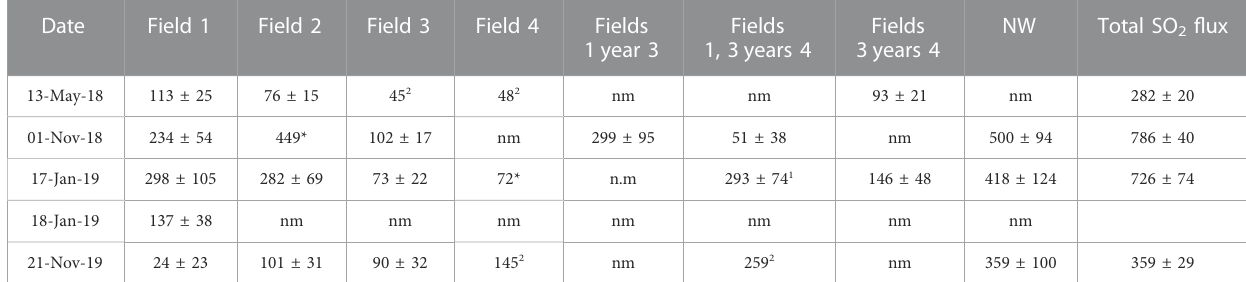
TABLE 5 SO 2 fl uxes obtained in the different measurements in t/d. The measured fi elds are indicated. nm: not measured; 1 Results presented only as a reference; 2Fluxesestimatedfromthedifferencebetweenthebulkplumeandindividualfumarolic fi eldsmeasurementsand/ordifferencebetweencombinedandindividual fumarolic fi